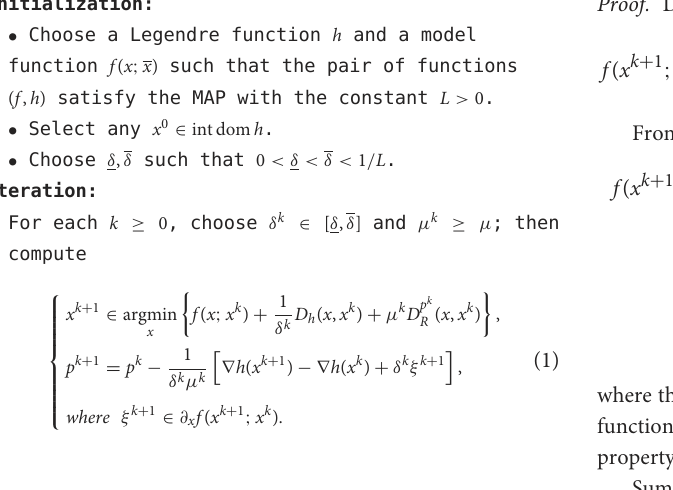
Algorithm 1. Bregman iterative regularization using model